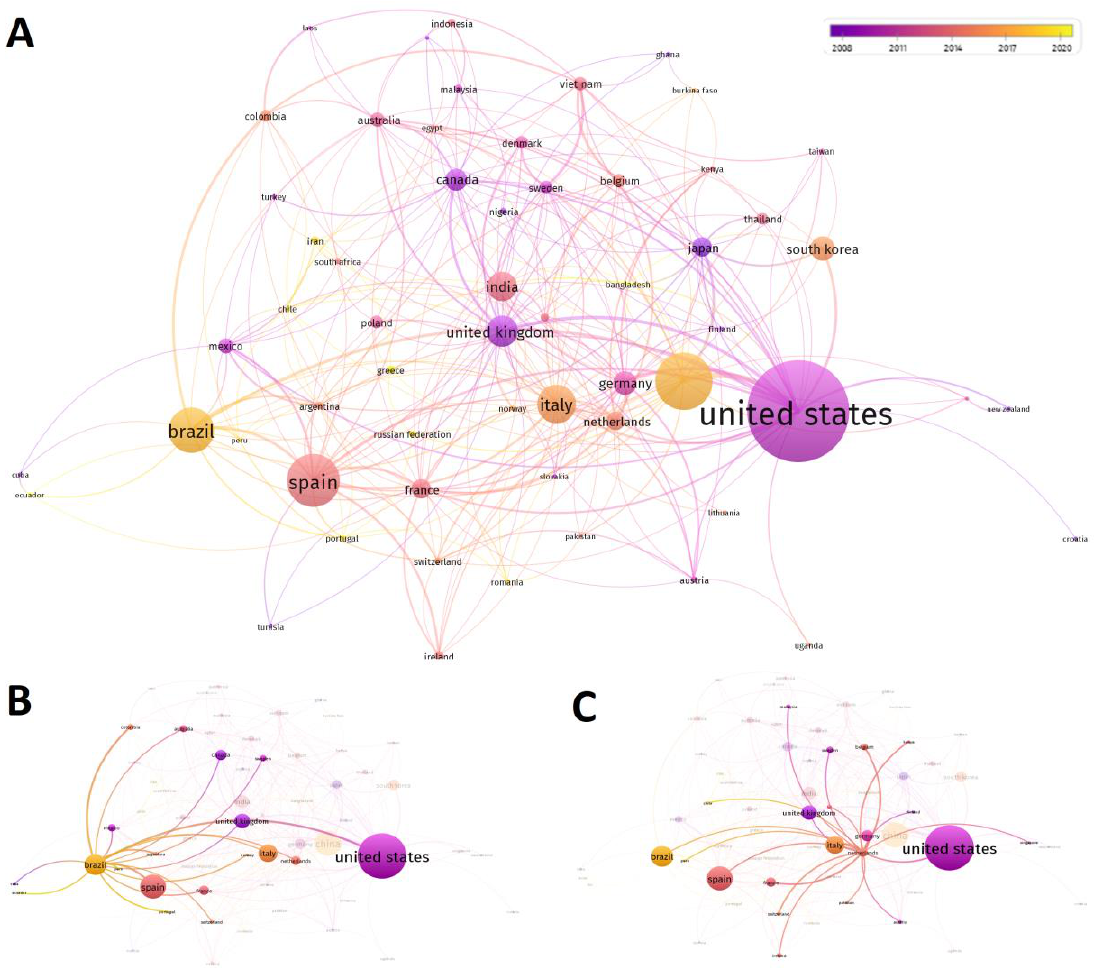
Figure 4. Co-authorship map showing the existing networks between countries involved in the publication of scientific articles related to the inclusion of agro-food waste in pig diets. ( A ) shows the global network of countries. ( B ) focuses on Brazil, and ( C ) focuses on the Netherlands. The size of the nodes indicates their frequency. The curves between the nodes represent co-occurrence in the same publication.